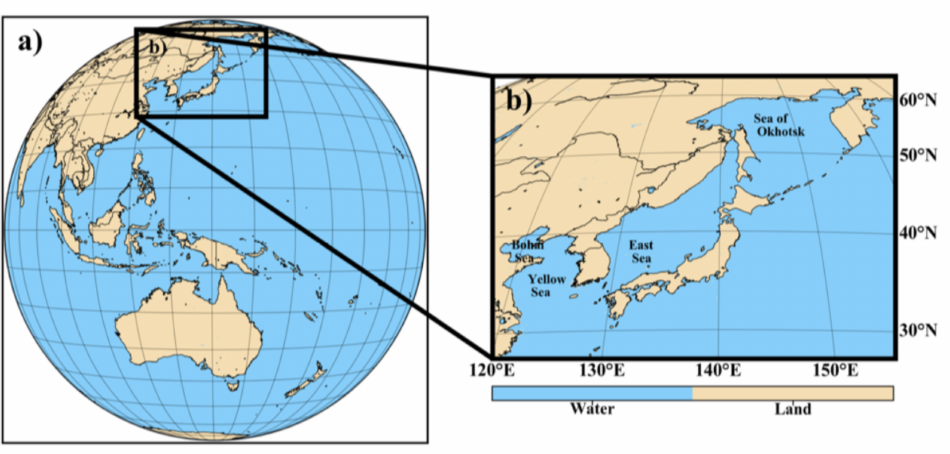
Figure 1. Study area on the GK-2A / AMI sea-ice detection algorithm, ( a ) Himawrai-8 / AHI full disk, ( b ) extended study area involving Okhotsk Sea and Bohai